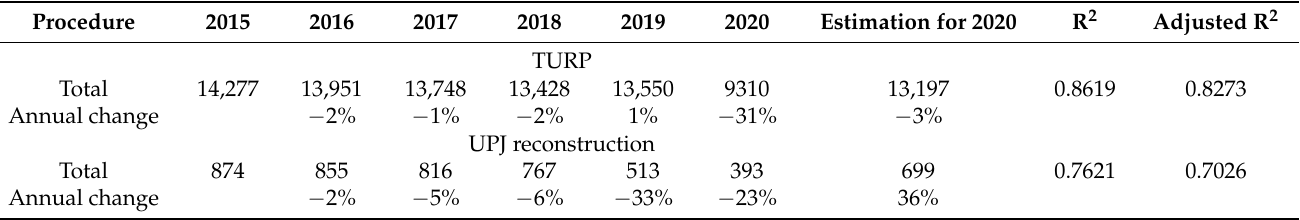
Table 3. Functional urology procedures registered in 2015 to 2020 and expected values for